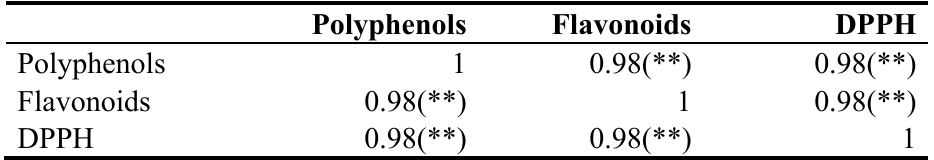
Table 2. Correlation matrix among the mean polyphenol and flavonoid contents and DPPH radical-scavenging activities (n = 3, three months, six months or twelve months) of the 14 investigated honey